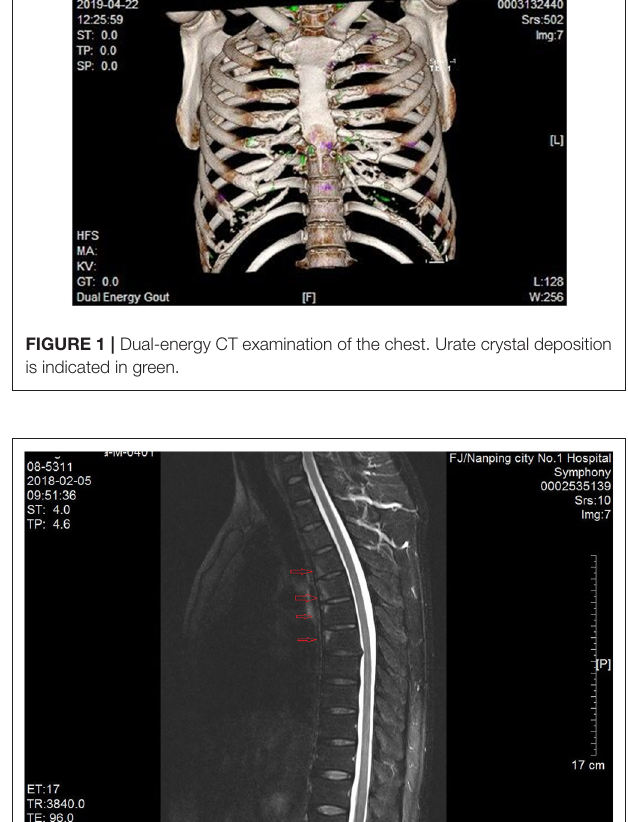
tumor markers, and other blood tests were